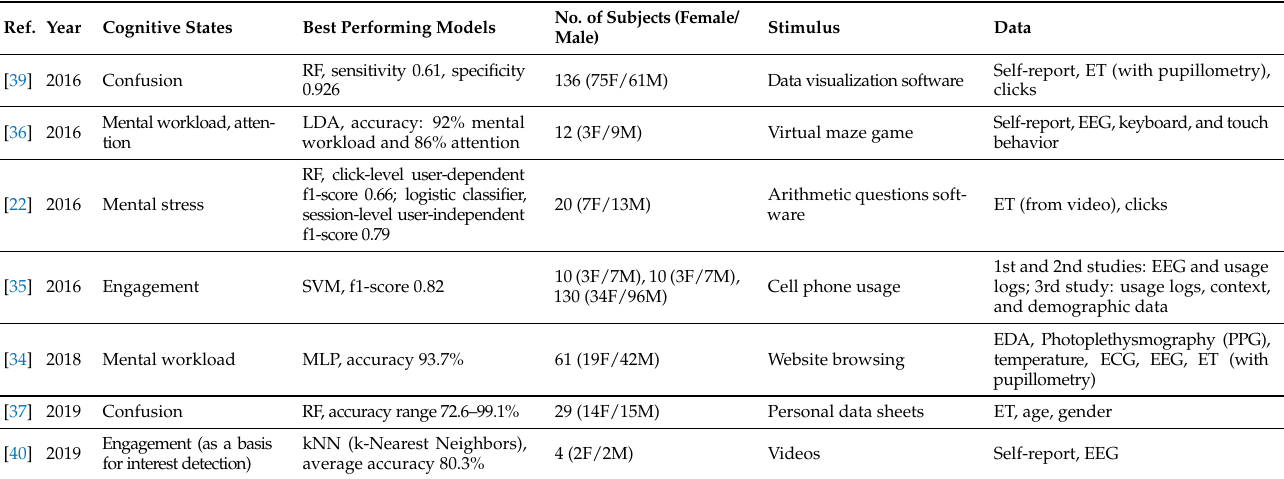
Table 2. Summary of papers with the classification of cognitive